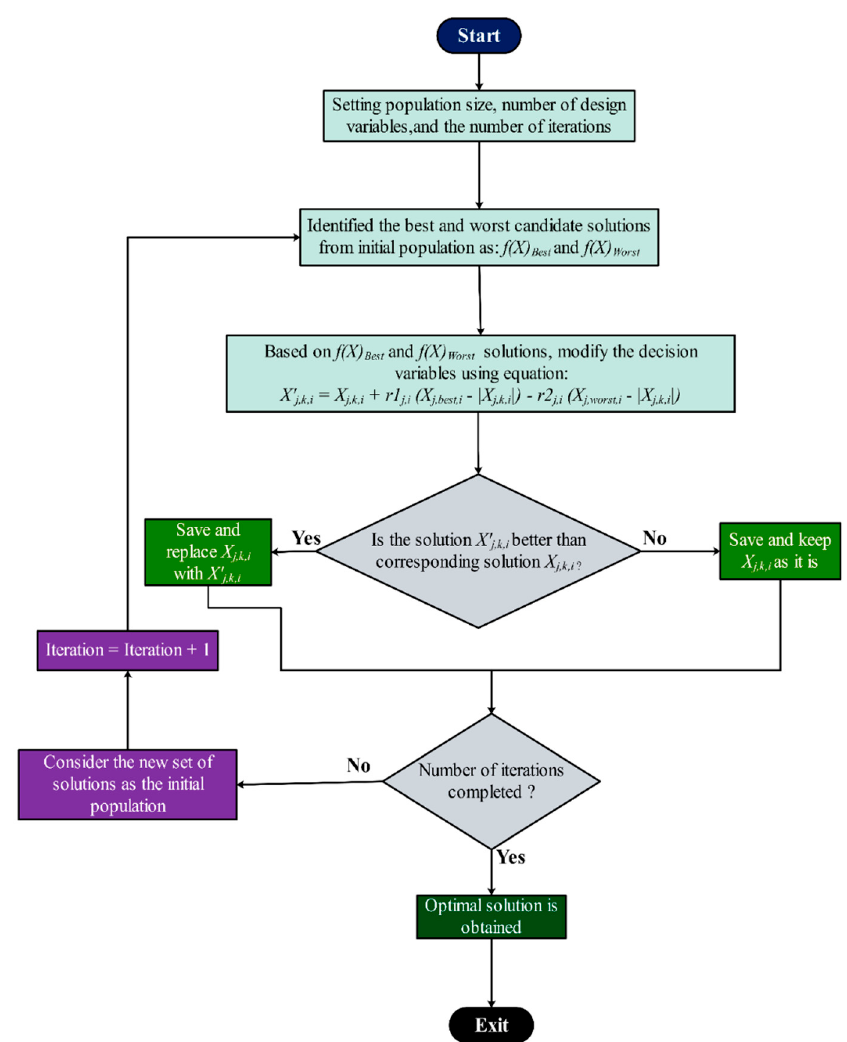
Figure 4. Flowchart of the Jaya algorithm.